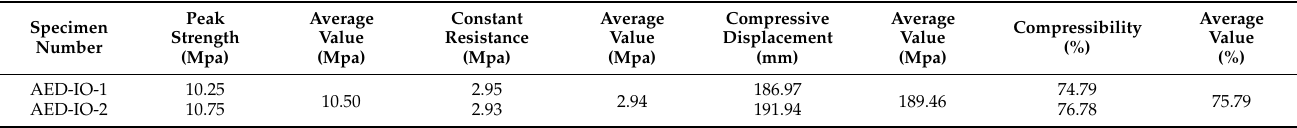
Table 3. Test results of the AED-IOs.